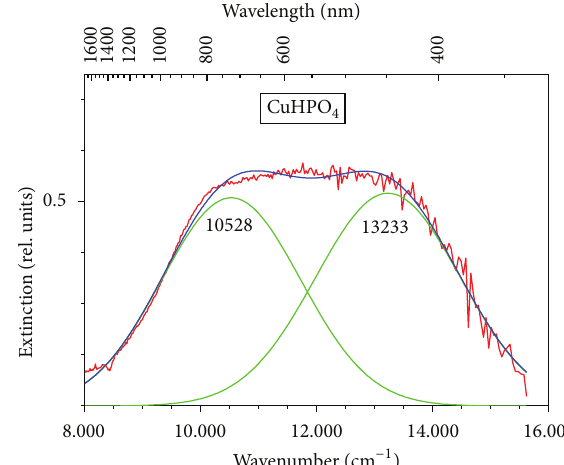
Figure 3: Peak fitting of the absorbance spectrum of CuHPo 4 (Origin).